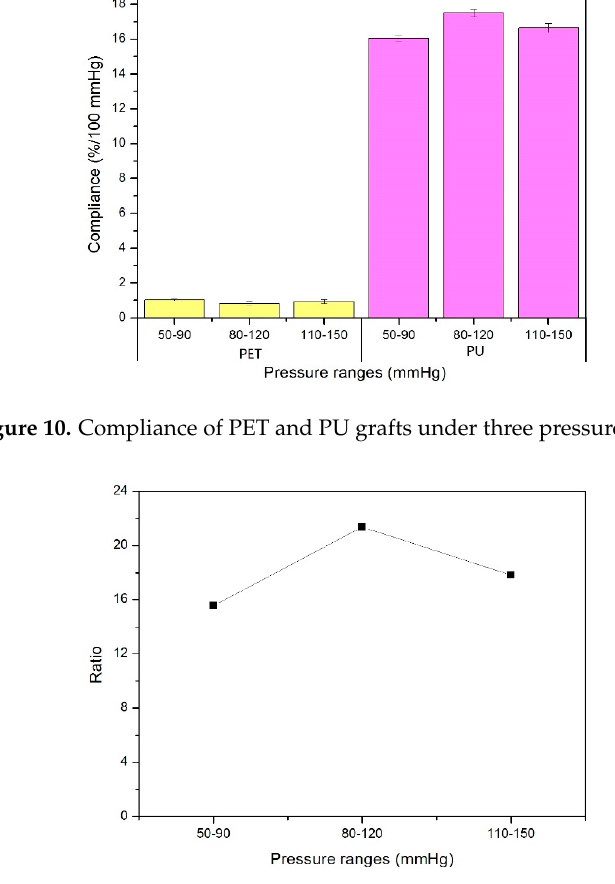
Figure 11. Ratio of compliance between PU and PET grafts.